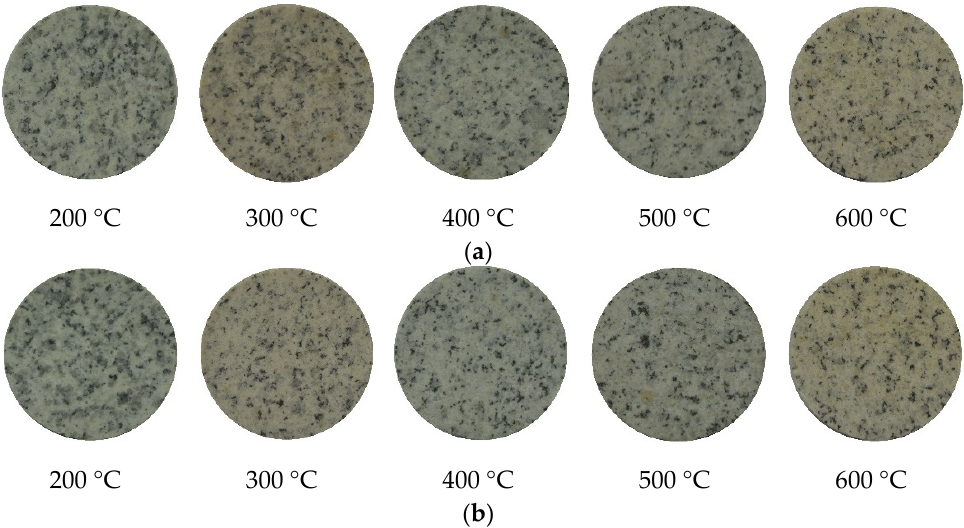
Figure 3. Surface morphology of granite with different cooling methods. ( a ) is the surface morphology of granite under natural cooling; ( b ) is the surface morphology of granite under cooling in